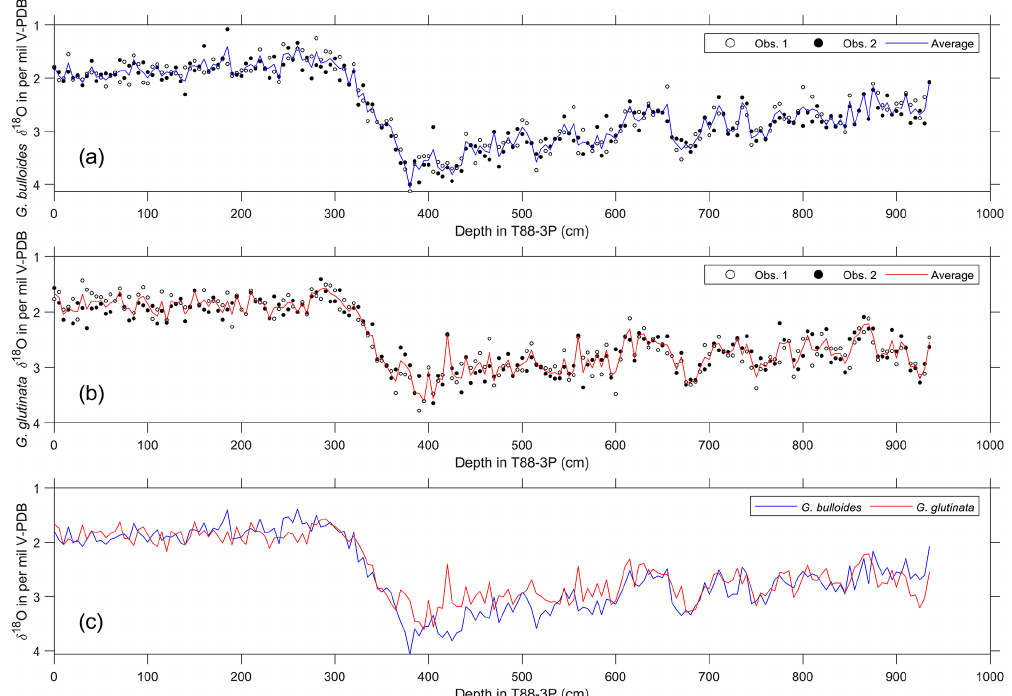
Figure 2. Raw pooled foraminifera stable oxygen isotope data and computed averages. (a) Pooled stable oxygen isotope data of G. bulloides and (b) G. glutinata ; for each sample, two groups (white and black dots) were measured and (c) the average was computed for both species (lines in a–c